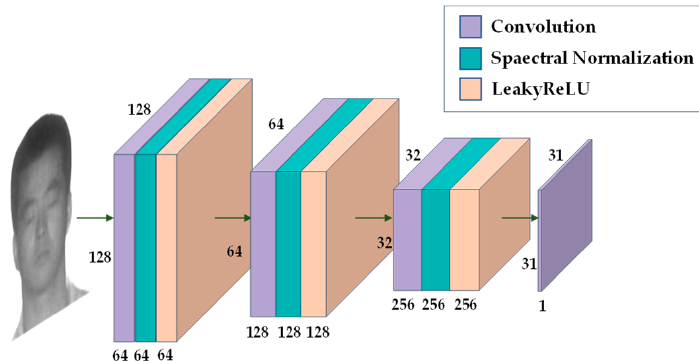
Figure 6. The architecture of the discriminator in the SN-CycleGAN.